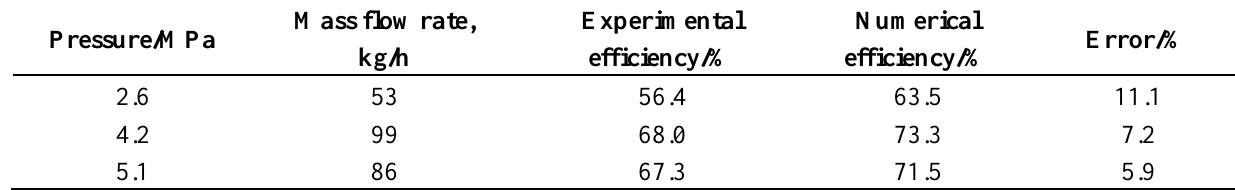
Table 2. Comparison of experimental and numerical